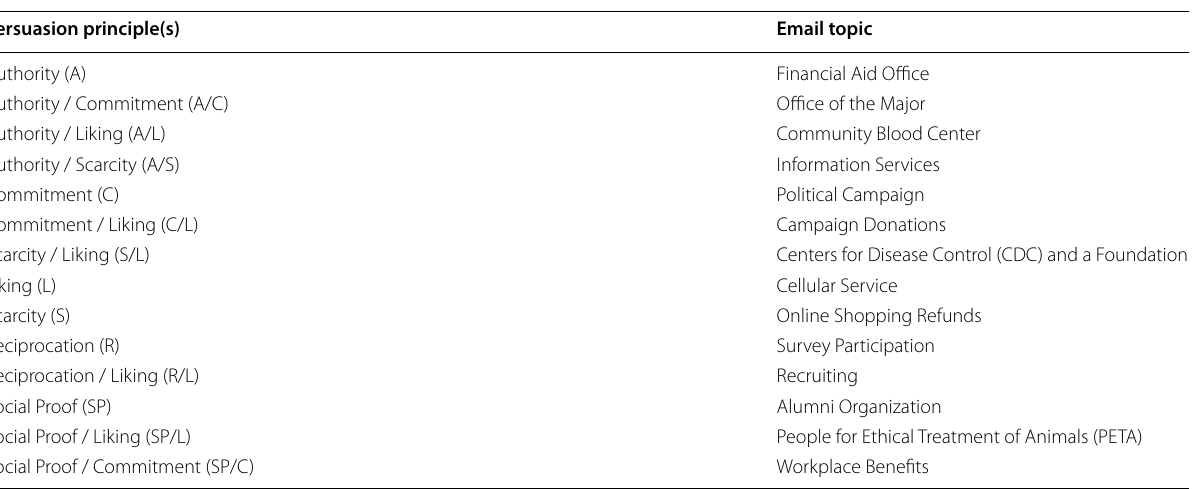
Table 2 Phishing email vignette